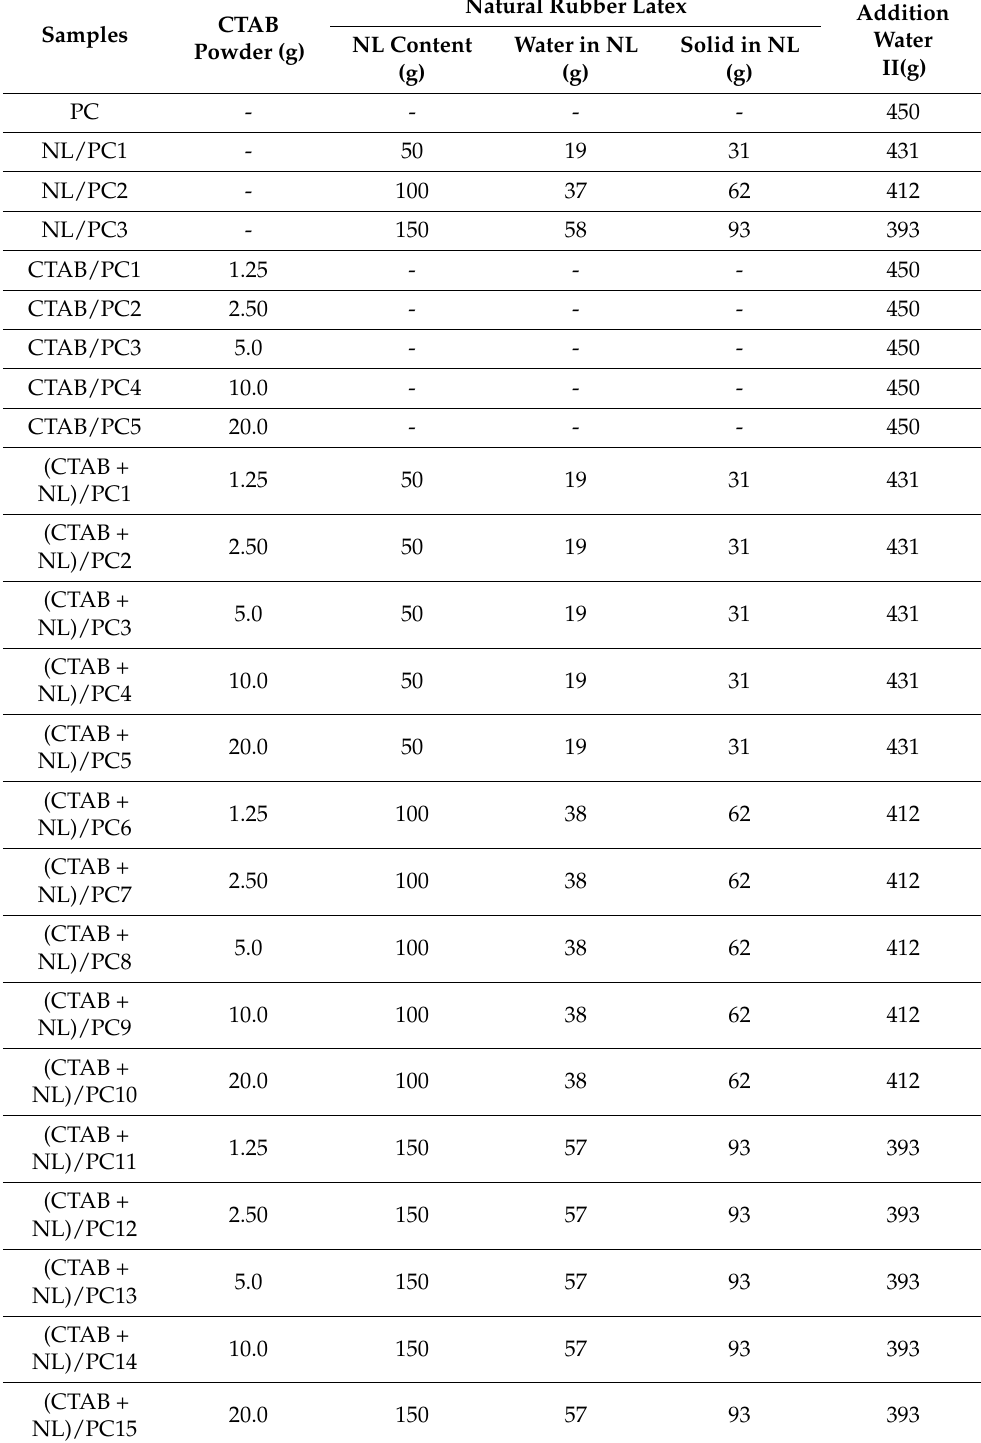
Table 3. Mixing proportions of cement pastes with 1000 g of Portland